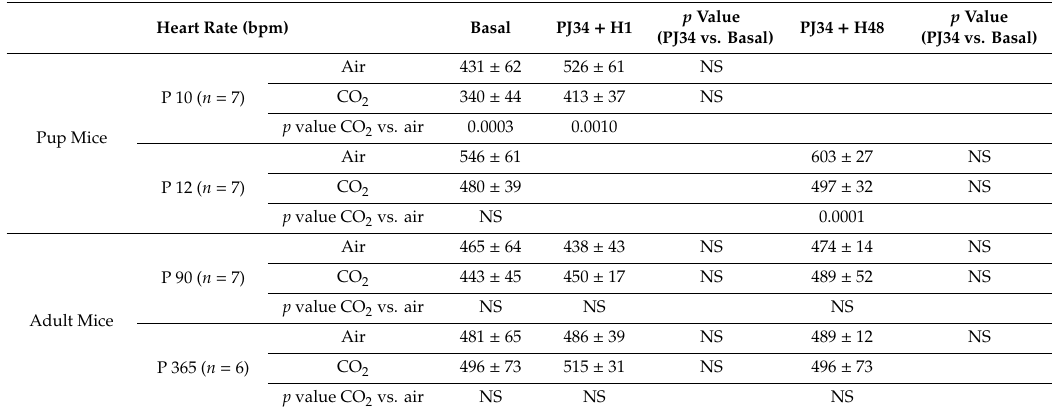
Table 3. Heart rate in control (naive) and PJ34-treated mice at di ff erent developmental stages under air and / or 5% CO 2 - 16% O 2 - 79% N 2